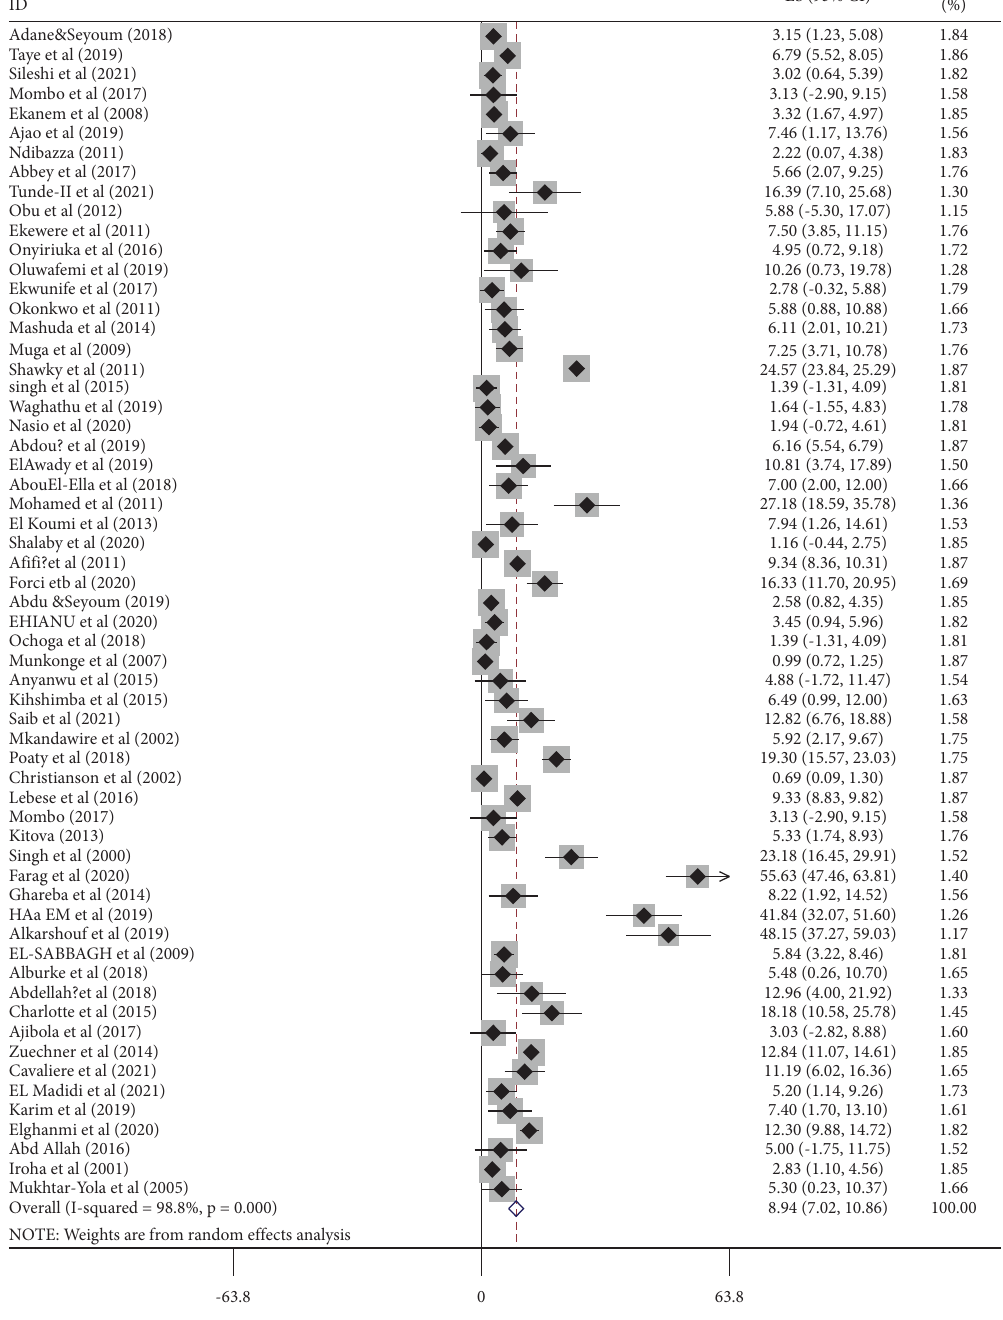
Figure 2: Forest plot on the pooled proportion of chromosomal disorders among births with congenital anomalies in Africa from January, 2000 to October,